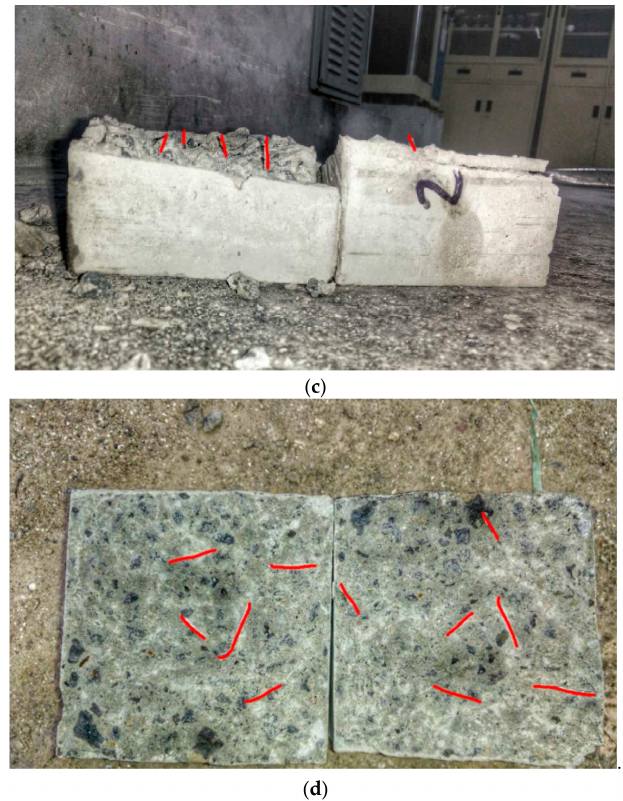
Figure 5. Fiber orientation in different concrete specimens: ( a ) NC-S1; ( b ) NC-M1; ( c ) MDC-S1; ( d ) MDC-M1.